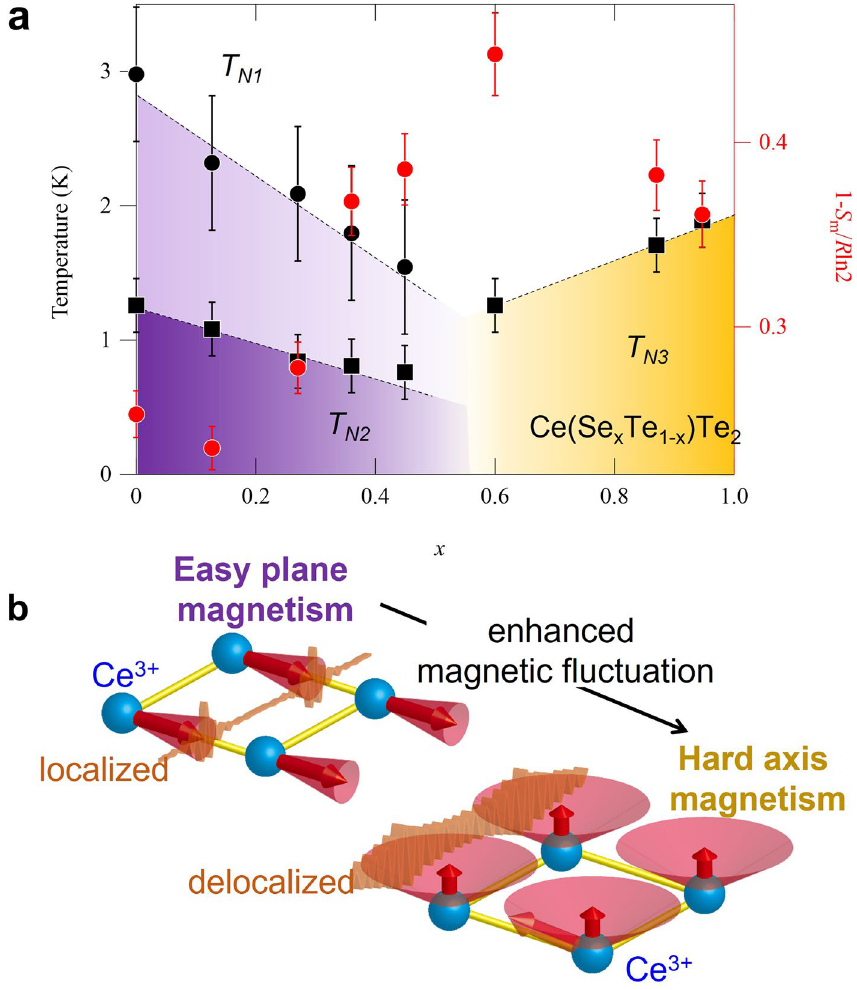
Figure 4. The phase diagram representing magnetic rotation associated with enhanced quantum fluctuation. ( a ) Temperature-doping phase diagram of Ce(Se x Te 1− x )Te 2 for three successive magnetic transition temperatures ( T N1 , T N2 , and T N3 ) and magnetic entropies 1 − S m / R ln2. The data used in this phase diagram are from specific heat measurements. ( b ) Schematic drawing of Fermionic order by disorder. The magnetic moment lies